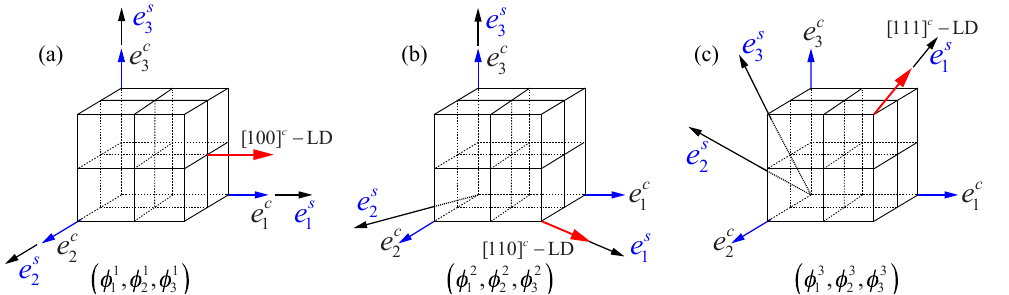
Figure 4. Loaded directions (LDs) in single crystal with respect to specimen orientation ( a ) [100]-LD , ( b ) [110]-LD, and ( c ) [111]-LD.